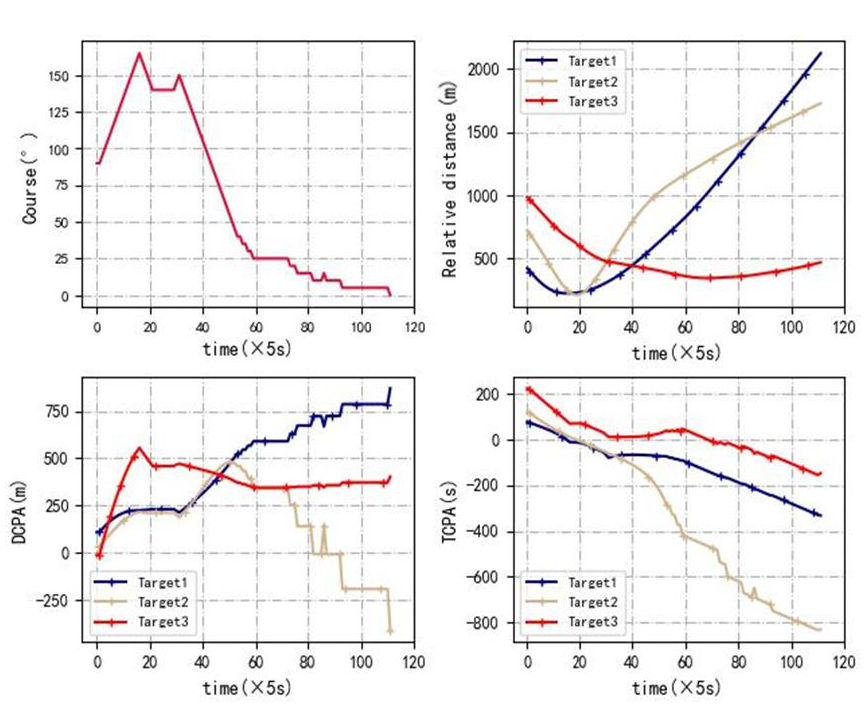
Figure 8. Course of ferry, relative distance, DCPA and TCPA when 𝑤 = 0.1.